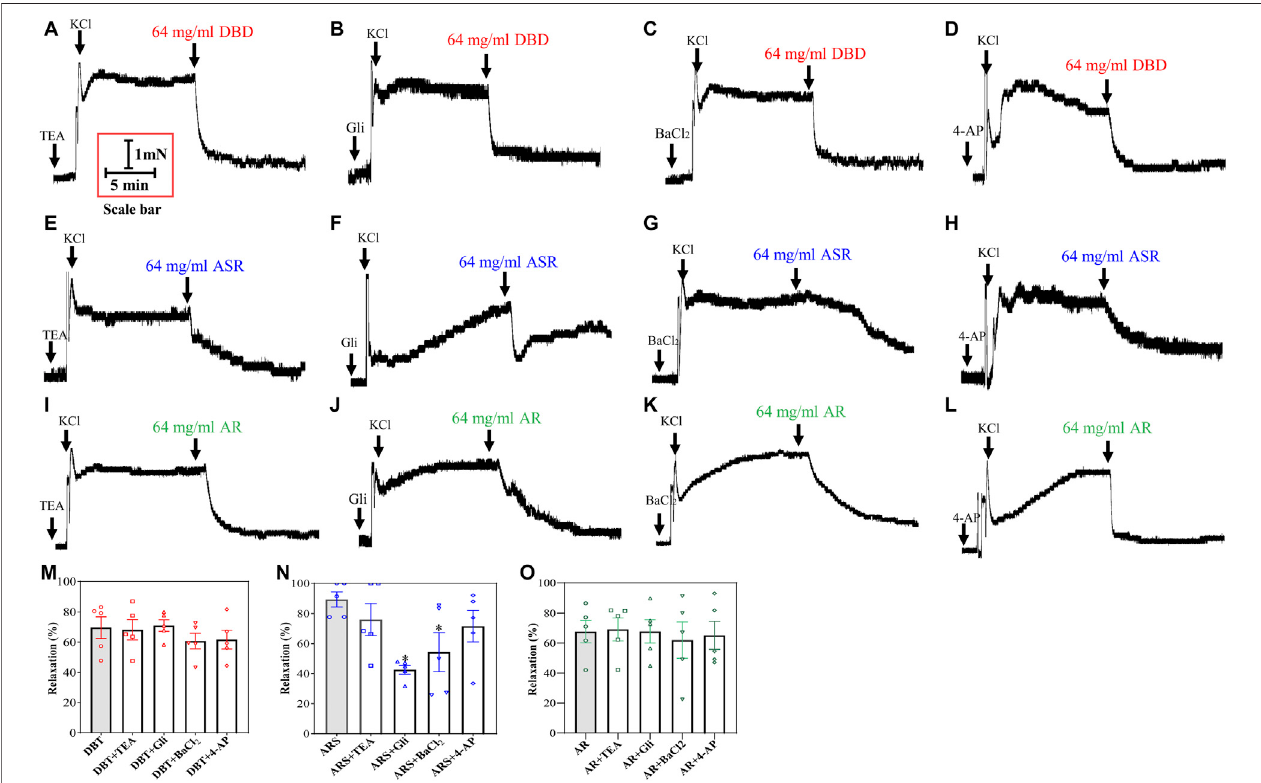
FIGURE9| Regulation ofDBD,ASR,andARonK + channels.PotentiallyinhibitingK + channelsopening(TEA,K Ca blocker;Gli,K ATP blocker;BaCl 2 ,K IR blocker;4- AP,K V blocker)byDBD (A – D ),ASR (E – H) ,andAR (I – L) on60 mMKClprecontractedMCAofrats.StatisticalresultsanddetailedvaluesofDBD (M) ,ASRDBD (N) ,and AR DBD (O) dilating MCA of rats by regulating four kinds of K + channels. K Ca , Ca 2+ -activated K + channel. K ATP , ATP-sensitive K + channel. K IR , inwardly rectifer K + channel. K V , voltage-dependent K + channel. Data were expressed as the mean ± S.E.M. (n (cid:2) 5). * p < 0.05 vs the control group. DBD, Danggui Buxue decoction. ASR, Angelicae Sinensis Radix. AR, Astragali Radix. MCA, middle cerebral